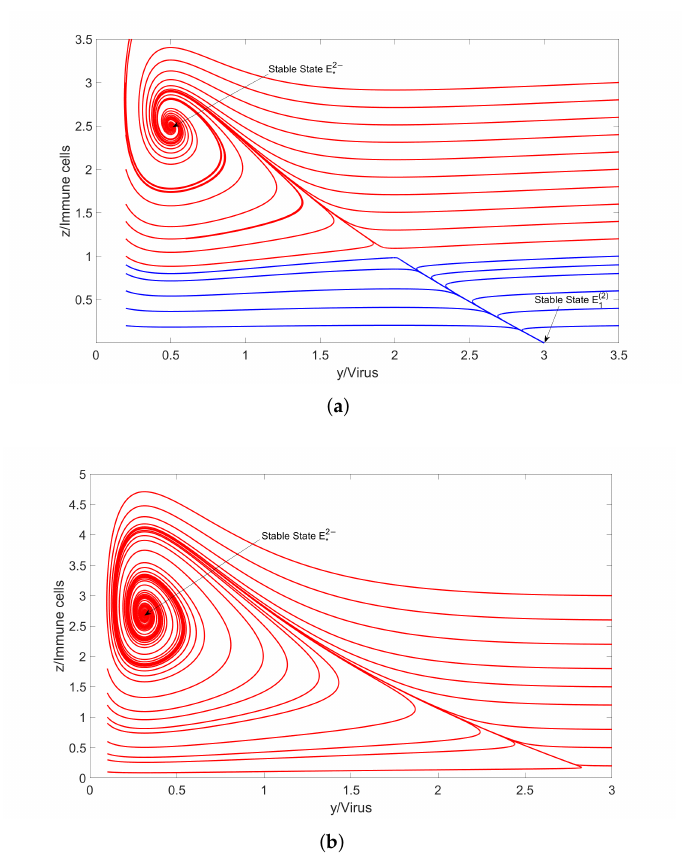
Figure 11. Trajectories of system (2) with different initial values for c = 3 day − 1 and c = 4 day − 1 . ( 2 ) When c = 3 day − 1 , E and E 2 − ∗ are stable. System (2) shows the bistable phenomenon (see ( a )). 1 When c = 4 day − 1 , only E 2 − ∗ is stable (see ( b )). Other parameter values are listed in Table 4 and K = 6 cells/ µ